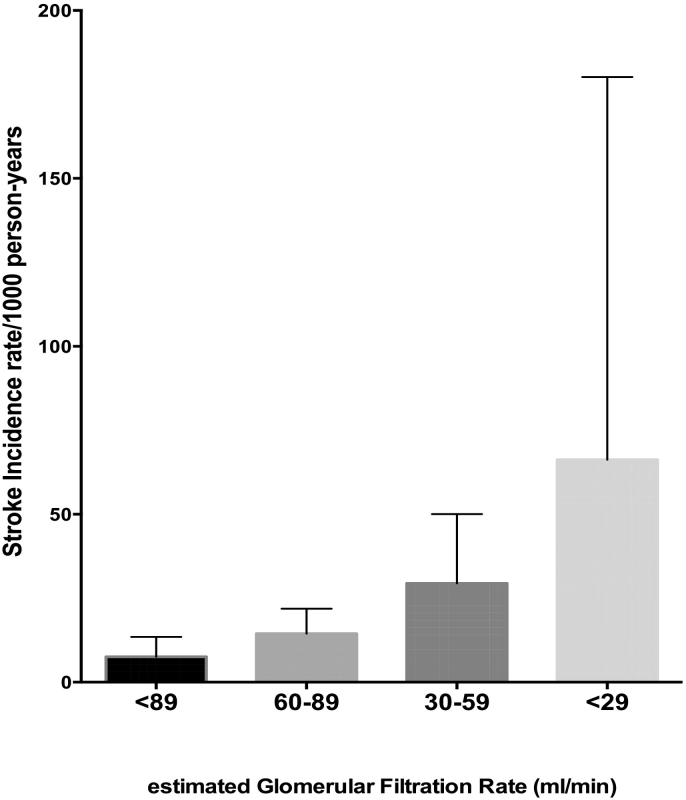
Incidence rates of stroke according to baseline estimated glomerular filtration rates among Ghanaians with hypertension and or diabetes. Each block represents incidence rate/1000 person years and bars represent upper limits of 95% Confidence intervals.